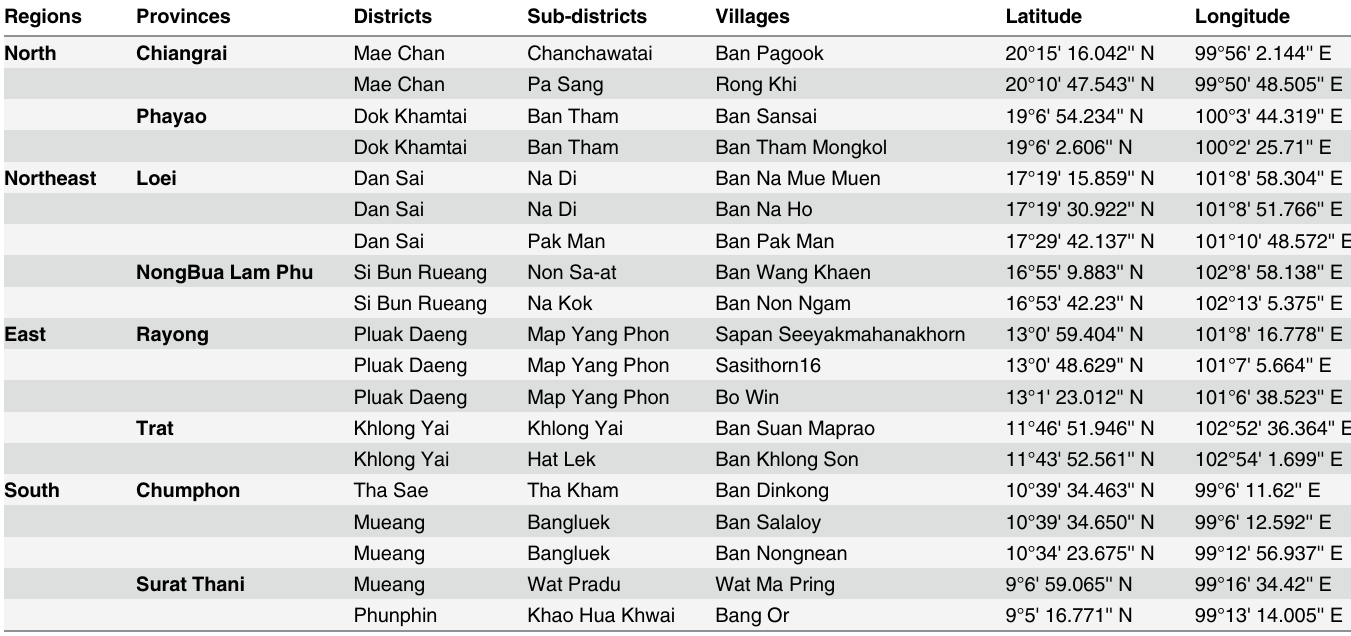
Table 1. Location coordinates of rodents and ectoparasites collection sites in Thailand (2012 –